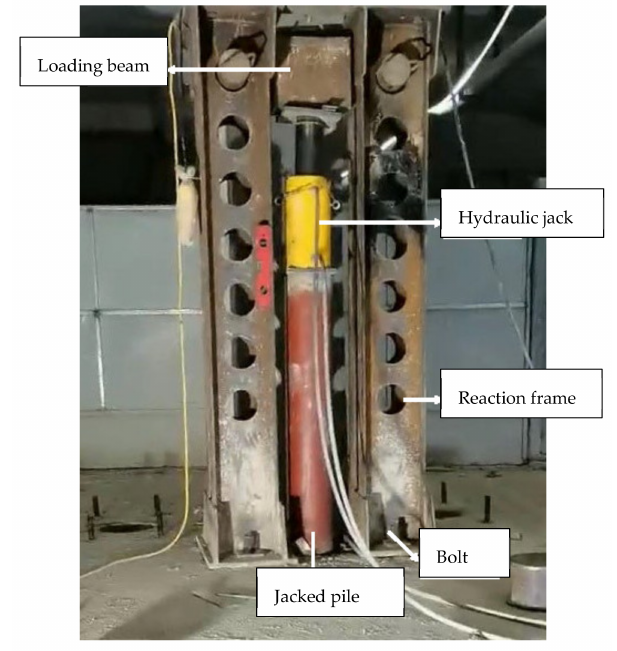
Figure 1. In situ test of small-diameter jacked